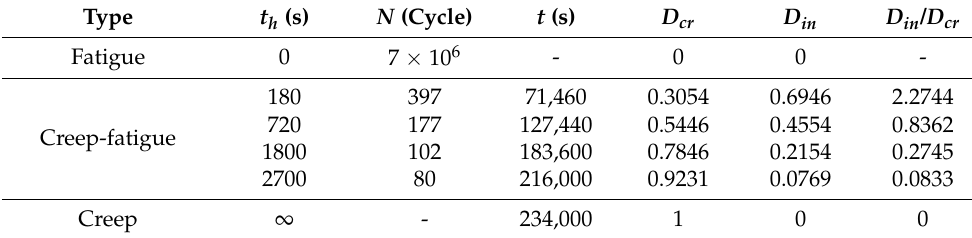
Figure 6. d a /d N for creep and interaction calculated by Equation (16). ( a ) T = 600 °C, R = 0.1; ( b ) T = Figure 6. da / dN for creep and interaction calculated by Equation (16). ( a ) T = 600 ◦ C, R = 0.1; ( b ) T = 700 ◦ C, 700 °C, R = 0.5; ( c ) T = 700 °C, R = 0.1; ( d ) T = 700 °C, R = 0.5. R = 0.5; ( c ) T = 700 ◦ C, R = 0.1; ( d ) T = 700 ◦ C, R = 0.5. Table 6. Life results for pure fatigue, creep-fatigue, and pure creep.